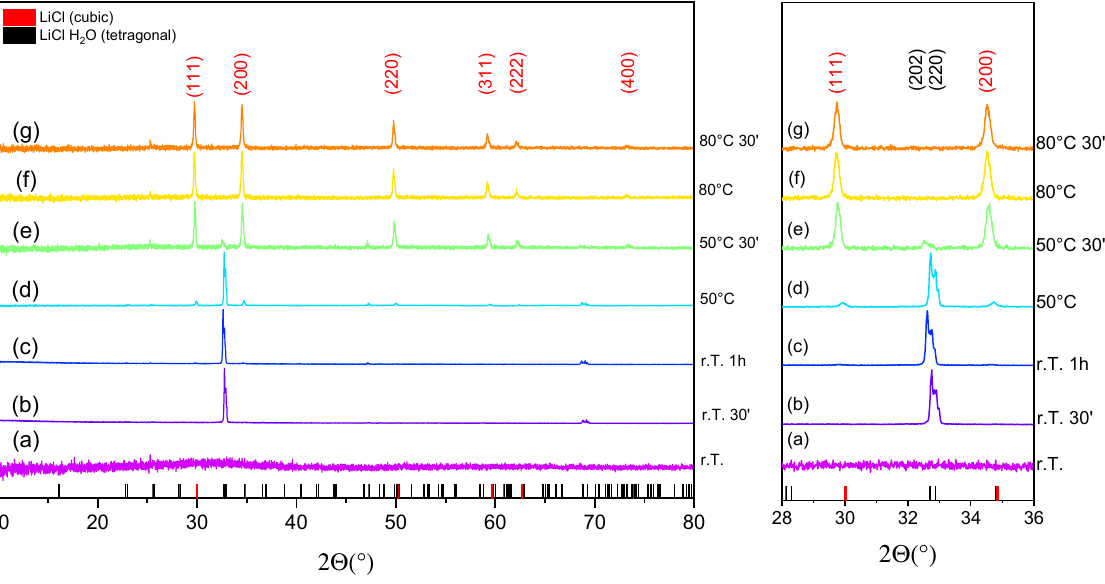
Figure 3. In situ XRD analysis of LiCl-PDMS foam under dry inert atmosphere while heating with measurement temperature as indicated ( ° C).